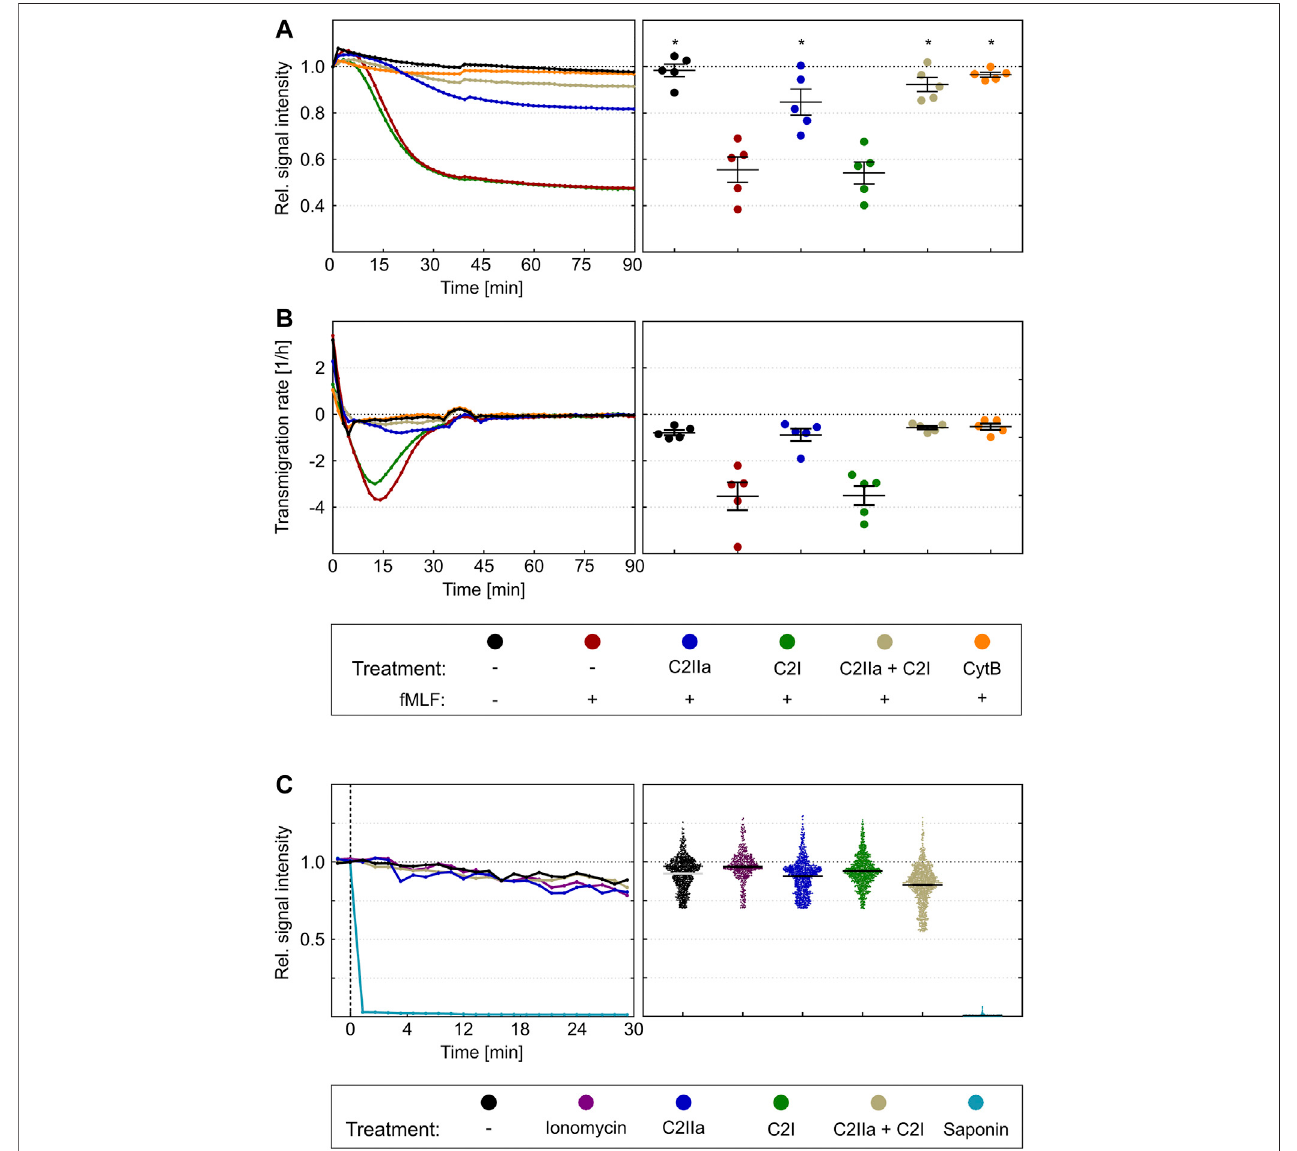
C2IIa + 1 μ g/ml C2I) or cytochalasin B (5 μ g/ml) as a positive control. After an intoxication time of 2 h, fMLF (10 nM) was added to the lower compartment to trigger chemotaxis. Calcein fl uorescence was measured from the top immediately after stimulation over a period of 90 min. The decline in signal intensity is considered to